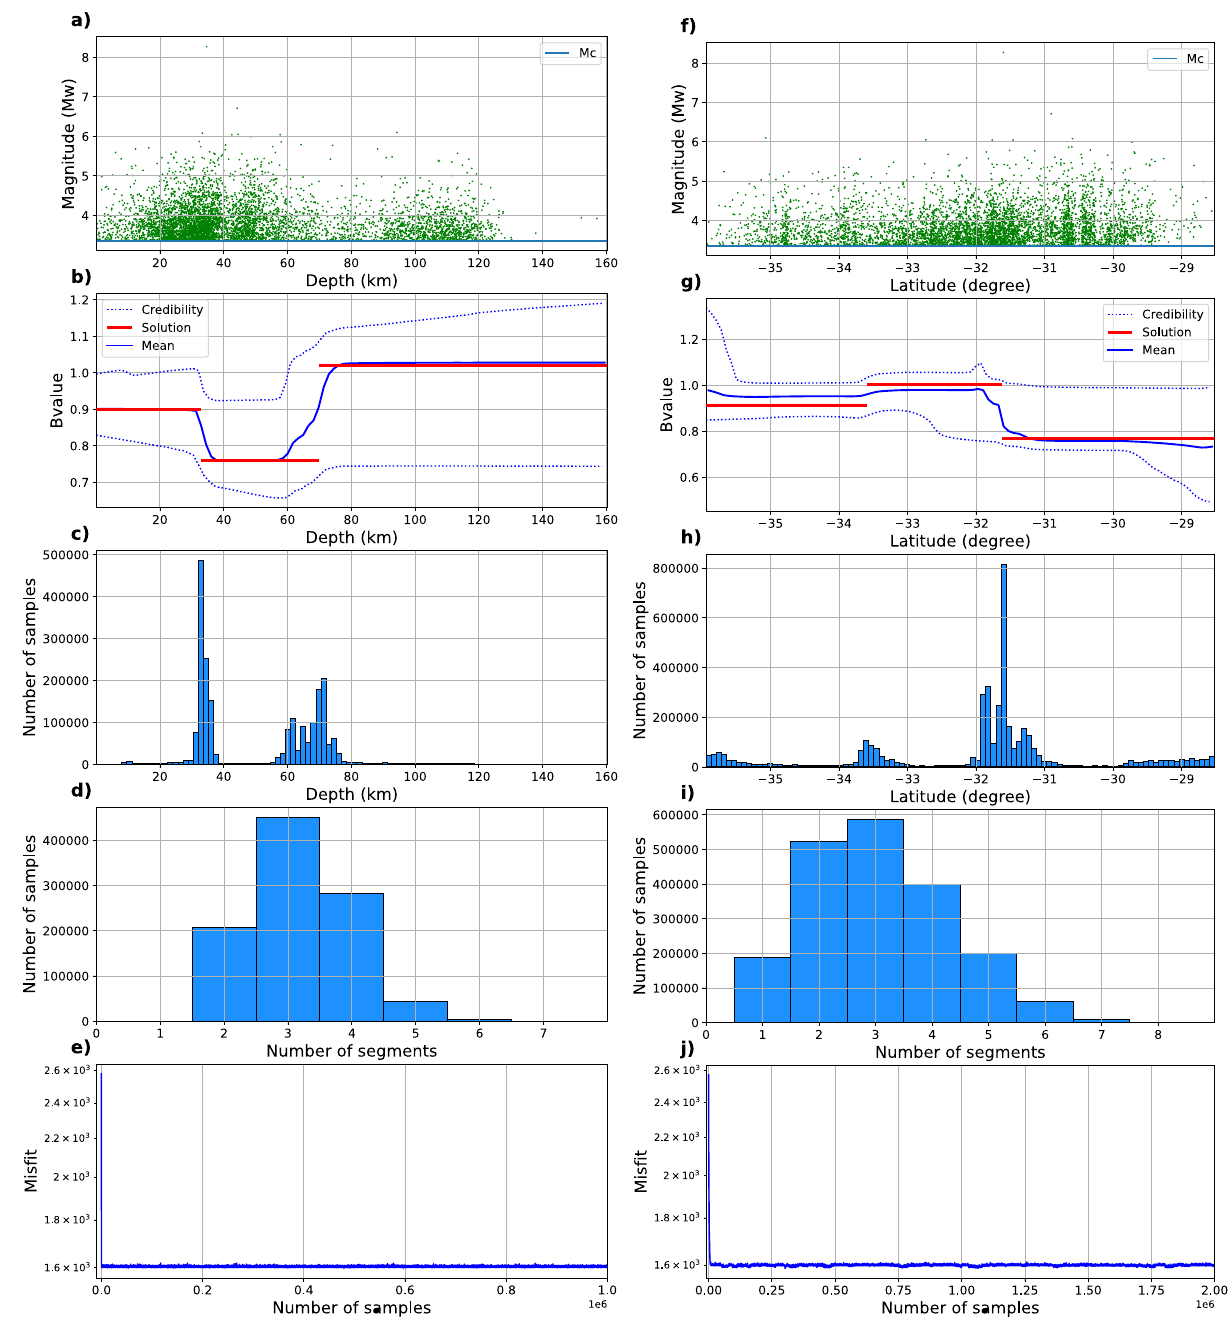
Figure 4. Applications of the rjMCMC to determine b-value variation as a function of depth ( a – e ) and latitude ( f – j ) for real data from Central Chile (5272 events in total). ( a ) and ( f ) Earthquake catalog as a function of the dependent variable. ( b ) and ( g ) Solutions obtained using rjMCMC: mean (blue), the best fit (red), and credibility interval (dotted blue). ( c ) and ( h ) Histograms representing the amount of samples that show b-value changepoints at a specific depth or latitude. ( d ) and ( i ) Histograms representing how many samples showed each number of segments. ( e ) and ( j ) Evolution of solution